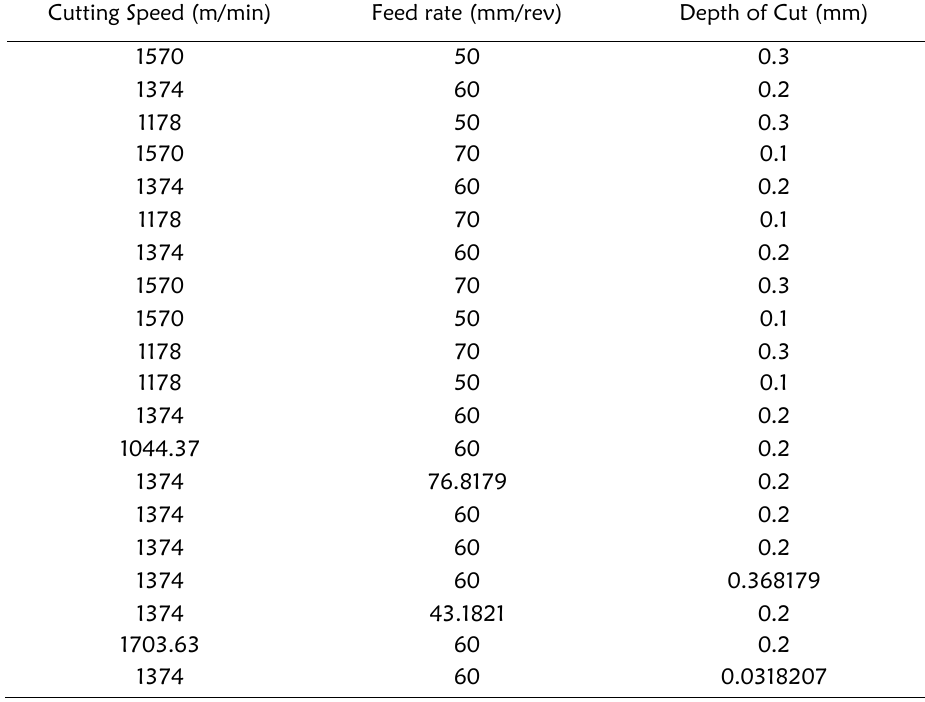
Table 2: Orthogonal Array for dry machining from Design Expert